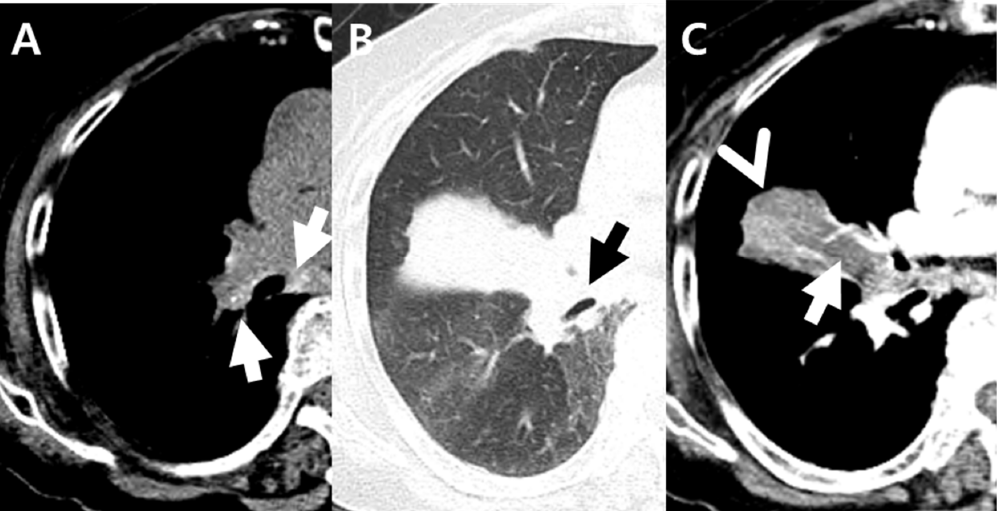
Figure 2. An 87-year-old woman with pulmonary tuberculosis and underlying bronchial anthracofibrosis presented with dyspnea. ( A , B ) Non-enhanced axial CT scan showed tiny hyperdense foci (white arrows) within enlarged peribronchial and mediastinal nodes and complete obstruction (black arrow) of right middle lobar bronchus, resulting in atelectasis of right middle lobe. These CT findings suggested bronchial anthracofibrosis. ( C ) Contrast-enhanced axial CT scan showed focal contour bulge (arrowhead) and internal low-density area (arrow) within atelectasis. These findings were the only CT findings suggesting pulmonary tuberculosis in this patient. Culture of Mycobacterium tuberculosis and polymerase chain reaction test for Mycobacterium tuberculosis were positive from bronchial washes. CT = computued tomography.